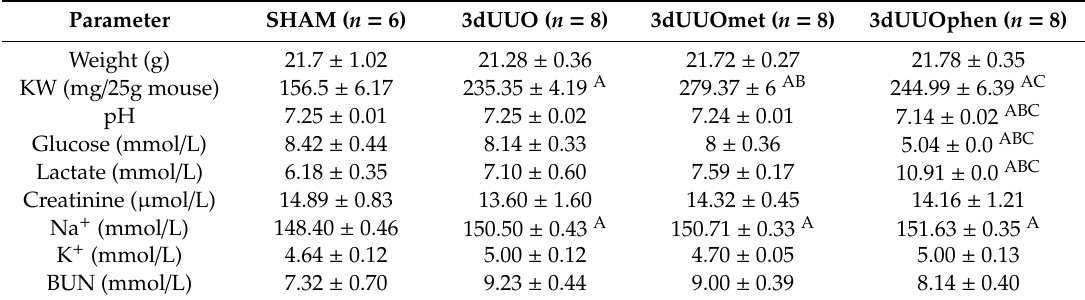
Table 3. Physiological